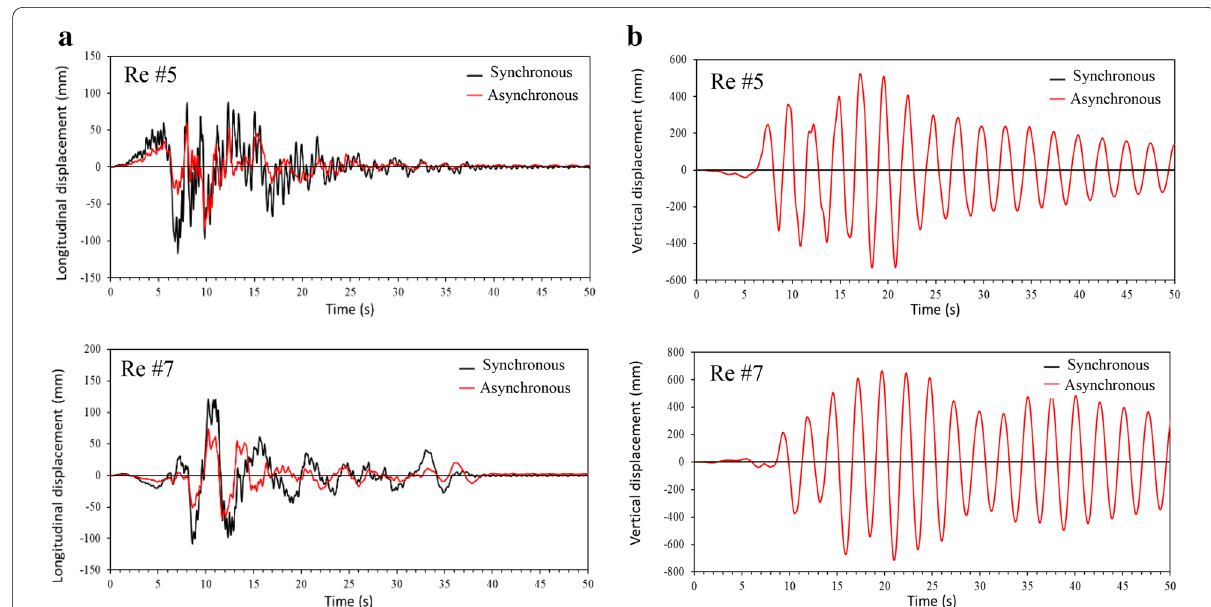
Fig. 6 Absolute displacement time histories for point A: a longitudinal displacement, b vertical displacement.